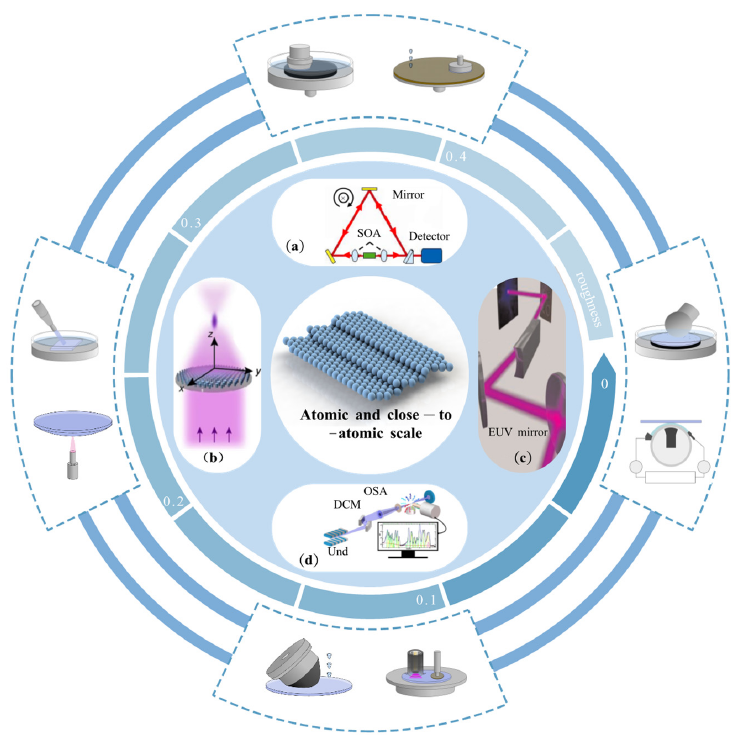
Figure 2. The demands and polishing approaches at ACS: ( a ) Measurement apparatus of the ring laser gyroscopes [40]; ( b ) Schematic drawing of focusing by a deep ultraviolet [41]; ( c ) Schematic of the tabletop extreme ultraviolet microscope [42]; ( d ) Schematic representation of an X-ray microprobe. Reproduced with permission from